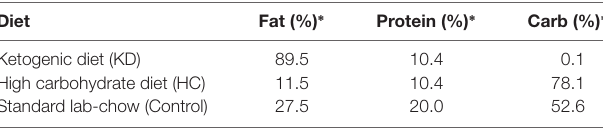
TABLE 1 | Macronutrient composition of mouse diets used in this study. Diet Fat (%) ∗ Protein (%)